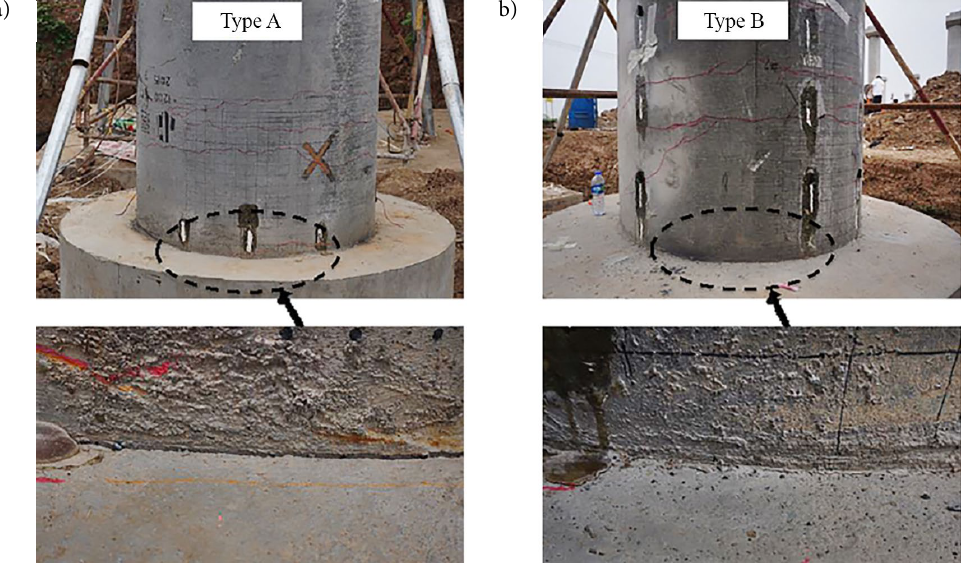
Figure 4. Cracks in column for type A and type B after test: a – Type A; b –